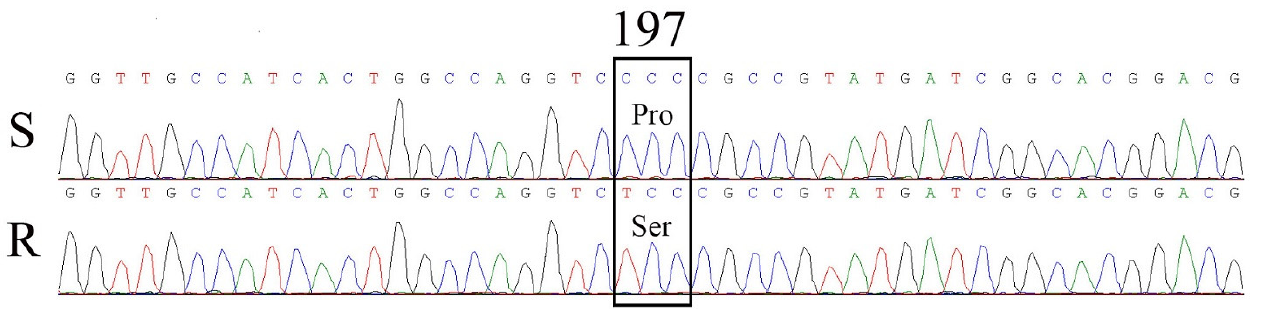
Figure 4. Comparison of the partial sequences of the ALS gene from the S and R populations. The amino acid position of the ALS gene was based on Arabidopsis.